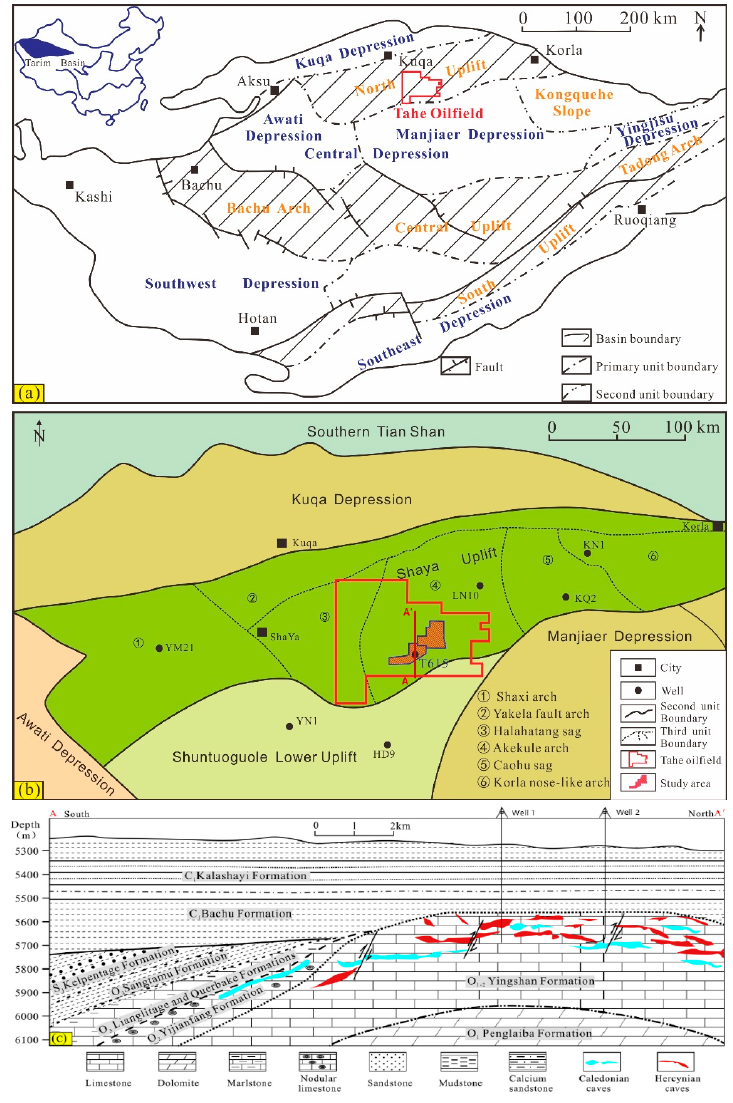
Figure 1. The location of the study area and an overview map of the Tarim Basin. ( a ) Tectonic components of the Tarim Basin, including three uplifts and four depressions with east–west orientations (modified from [17]). The Tahe oilfield is located in the Northern Uplift of the Tarim Basin. ( b ) The study area is in the center of the Tahe oilfield, which is located in the southwestern part of the Akekule Arch in the Northern Uplift of the Tarim Basin (modified from [18]). ( c ) Cross Section A-A’, showing the paleokarst system of the Tahe Oilfield. The main reservoirs are located in the northern part of the Tahe Oilfield in the Yingshan Formation (O1–2 years), which is at depths exceeding 5500 m (modified from [2]). See Figure 1b for the cross-section